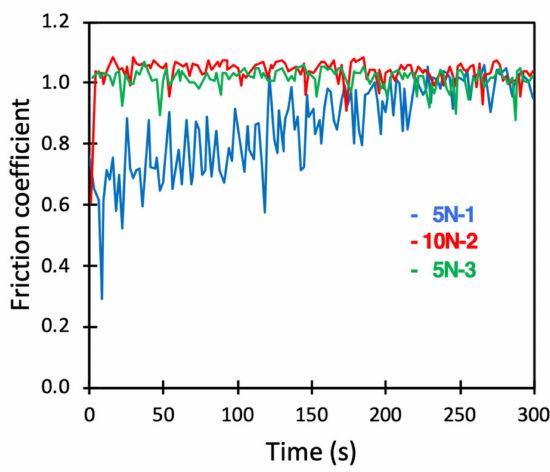
Figure 6. Friction coefficient between borosilicate surfaces carrying a preadsorbed DPPC bilayer across PBS solution. Numbers 1, 2 and 3 displayed after the load (5 N or 10 N) report the order in which the load was